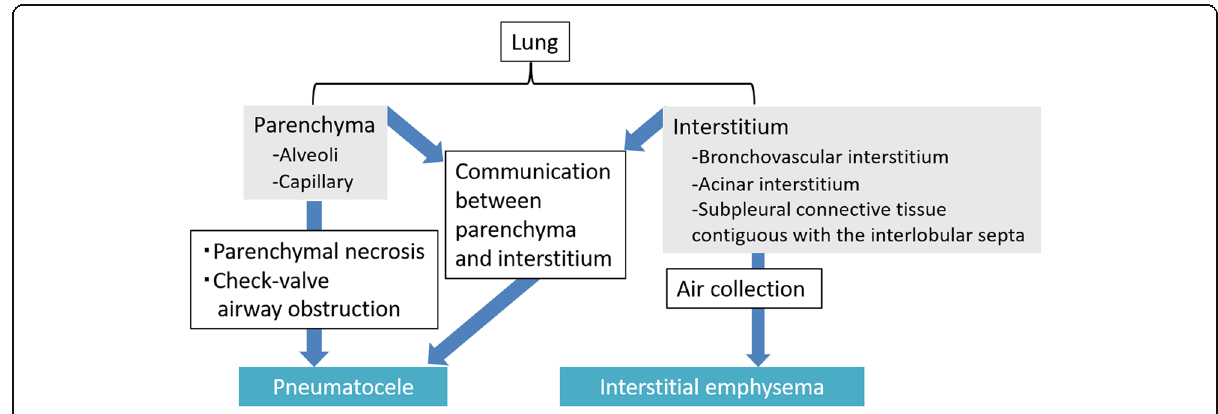
Fig. 20 Anatomy of the lung and diseases of abnormal air collection in each anatomical